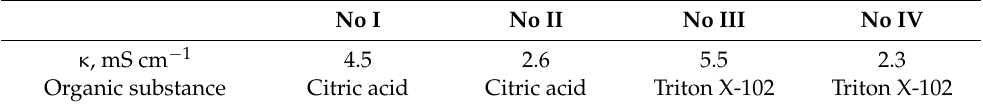
Table 2. Schematic composition of model solutions.